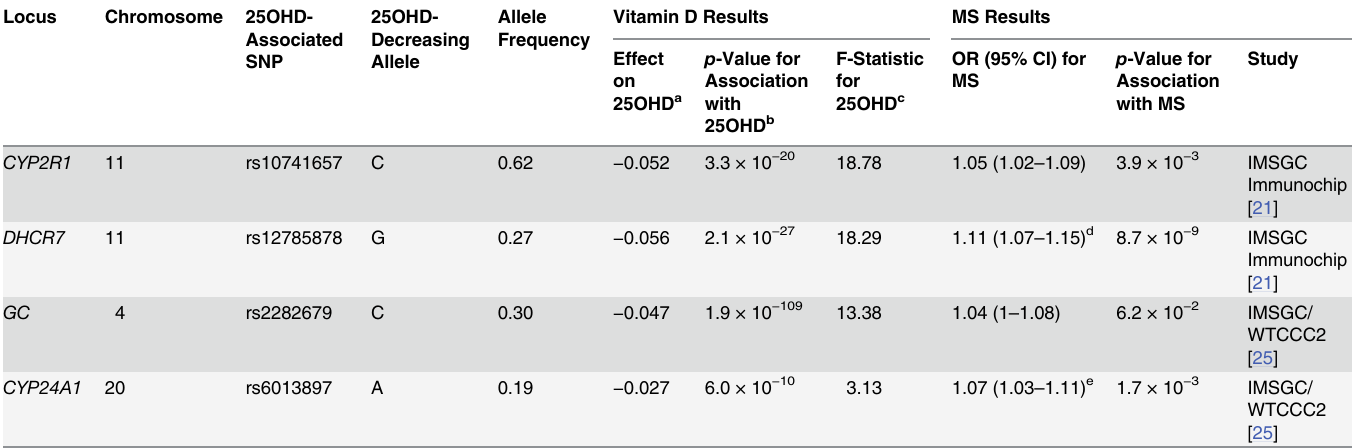
Table 1. Characteristics of SNPs used as instrumental variables. Locus Chromosome 25OHD-